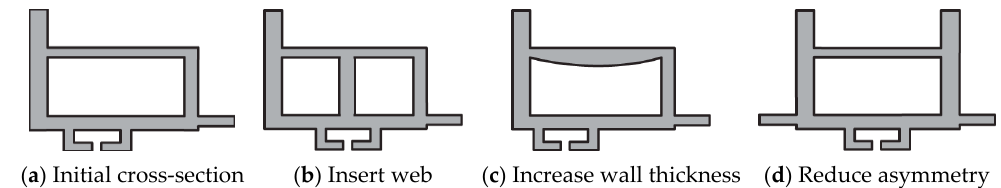
Figure 3. Modifications made to reduce cross-sectional deformation and twisting according to a production-correct design [7].